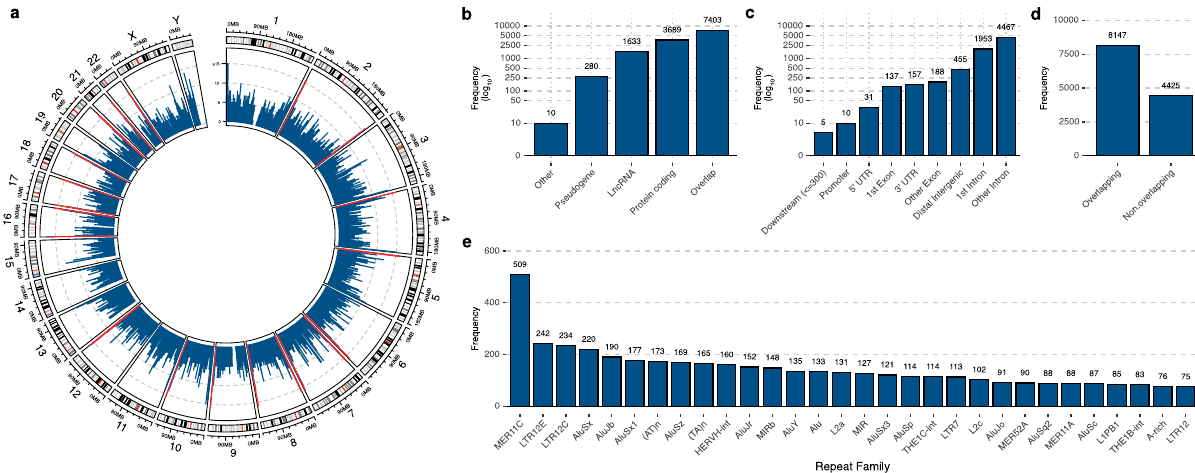
Fig. 2 Genomic representation of the hCRISPRs. a Genomic location of the hCRISPRs ( n = 12,572) visualized as an ideogram, each window represents a human chromosome (chromosome 1:22 and XY). The y -axis of the data-tracks shows the number of hCRISPRs, binned per genomic Mb (in blue; bins with >15 hCRISPR are colored red). b Overlap of the hCRISPRs with known annotations from GENCODE v33 (transcript support level 1 and 2). Overlap was based on a minimum of fi ve base pairs between hCRISPR foci and gene foci; several hCRISPRs overlap with >1 gene. Frequencies ( x -axis) are plotted on a log 10 scale. c Overlap of the hCRISPRs with known genetic features from GENCODE v33 (transcript support level 1 and 2). Overlap was based on a minimum of fi ve base pairs between hCRISPR foci and gene foci; several hCRISPRs overlap with >1 gene. Frequencies ( x -axis) are plotted on a log 10 scale. d Overlap of the hCRISPRs with known human repeat families. Overlap was based on a minimum of fi ve base pairs between hCRISPR foci and repeat foci; several hCRISPRs overlap with >1 repeat. e Top 30 (based on frequency) of repeat families overlapping with the hCRISPRs.